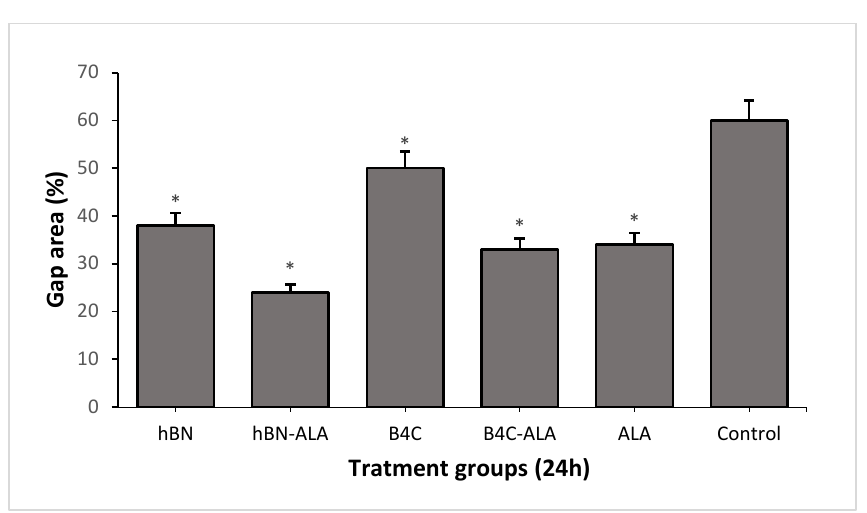
Figure 6. The wound gap distance for the all groups after 24 h. Symbol (*) represents statistically significant difference ( p ≤ 0.05) compared to the negative control.